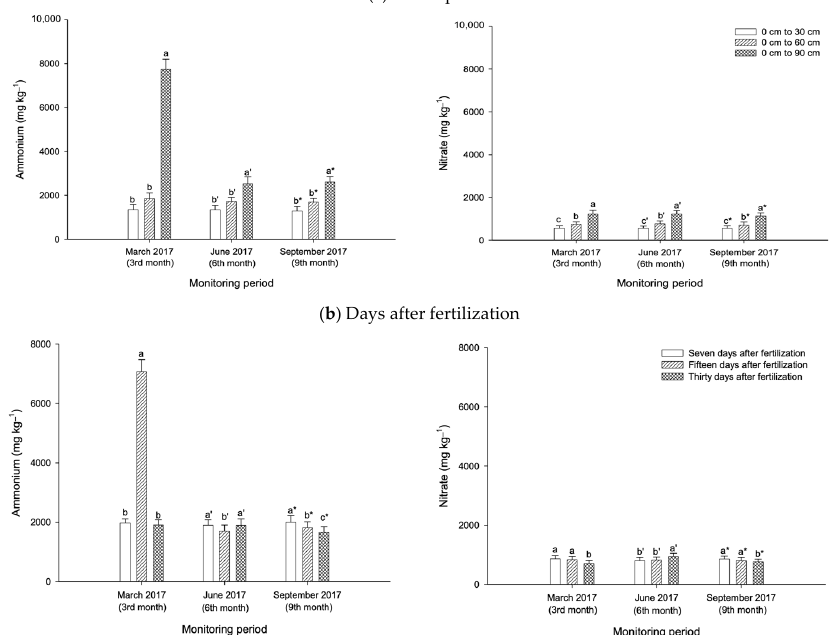
Figure 8. Mean losses of ammonium and nitrate from peat soils cultivated with pineapple ( a ) ac- cording to soil depth and ( b ) after fertilization overall treatments (T1 to T6). Error bars indicate the standard error of the mean (n = 486). Means with different letters are significantly different using Tukey’s test with p ≤ 0.05. CZ: clinoptilolite zeolite. Letters without primes, single primes, and as- terisks represent ammonium losses at the end of the wet season.